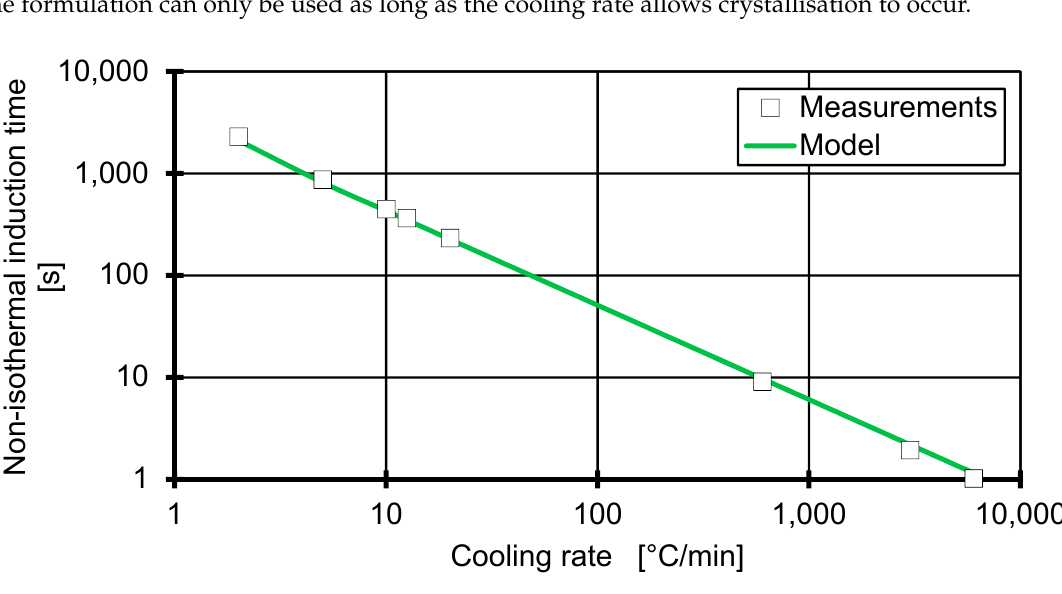
Figure 6. The markers show the time to reach the onset crystallisation temperature in a non-isothermal cooling with constant cooling rate. The time reference ( t = 0) is chosen to be the crossing point of the equilibrium melting temperature.